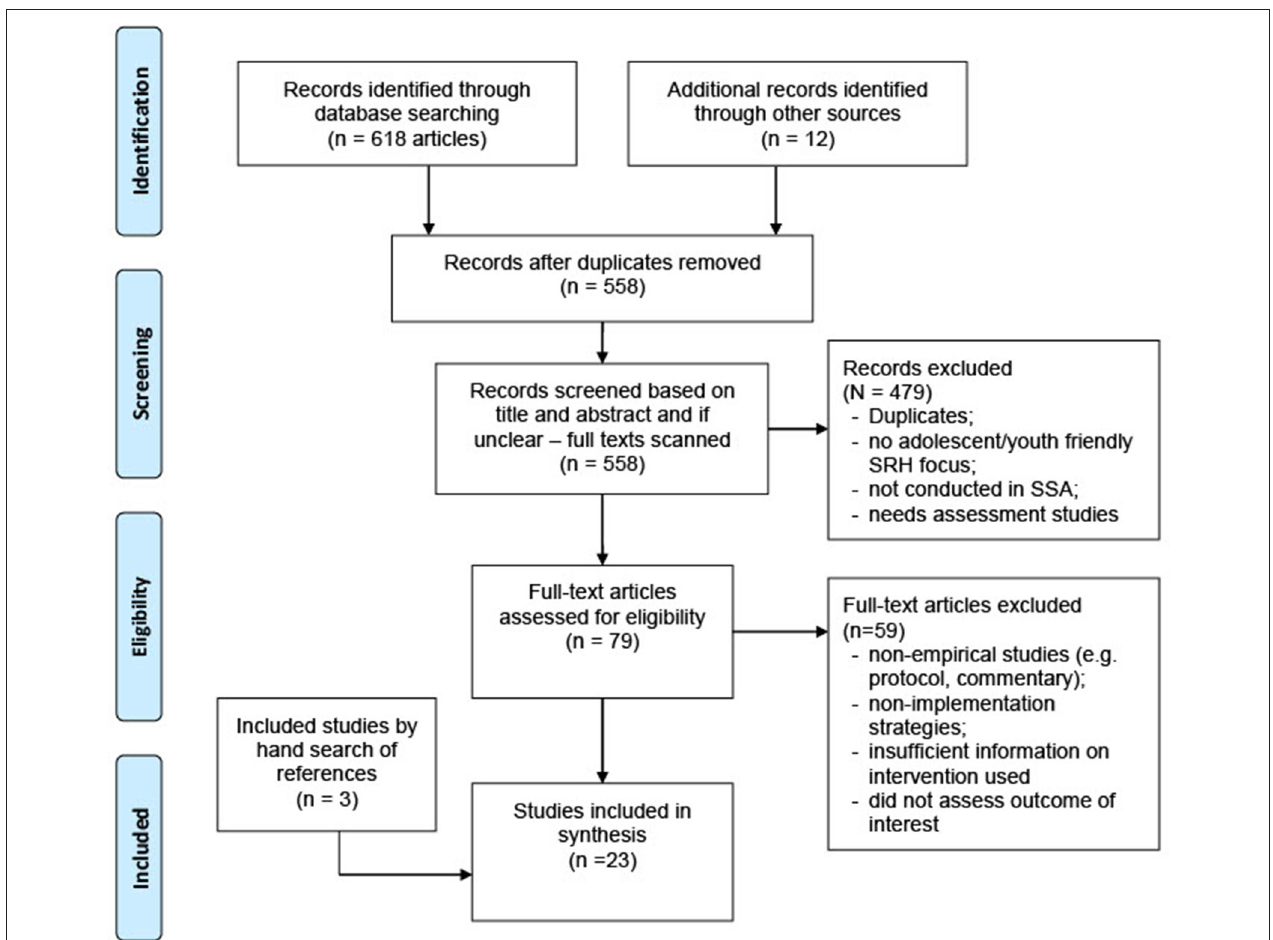
FIGURE 1 | PRISMA flow